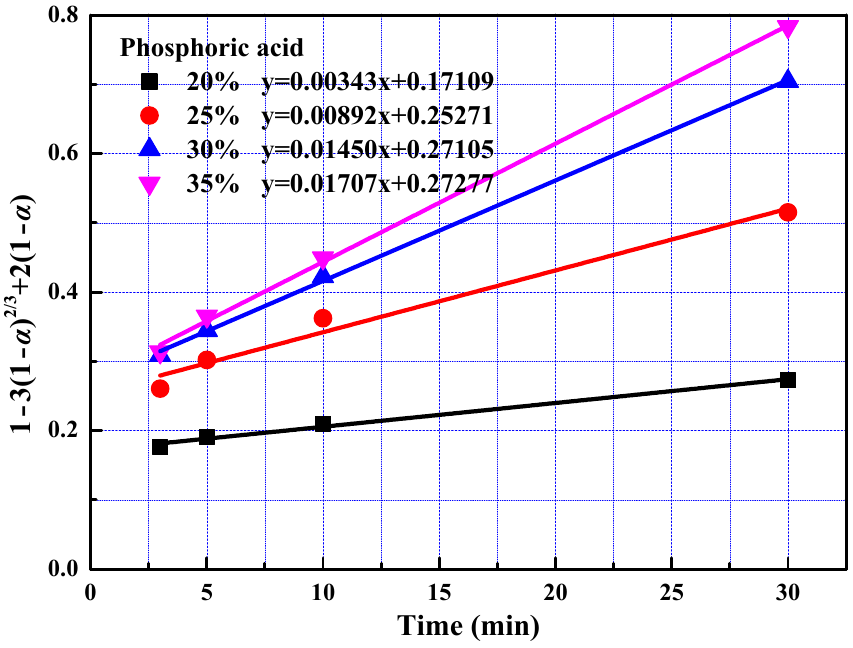
Figure 11. The relationship between 1 − 3(1 − α ) 2/3 + 2(1 − α ) and leaching time during the slow reaction stage at different phosphoric acid concentration.